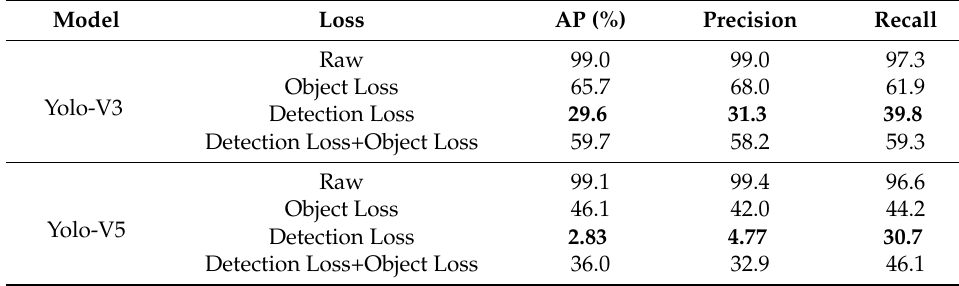
Table 7. Comparison of attack effect on AP, precision, and recall. Bold fonts indicate the best effect.